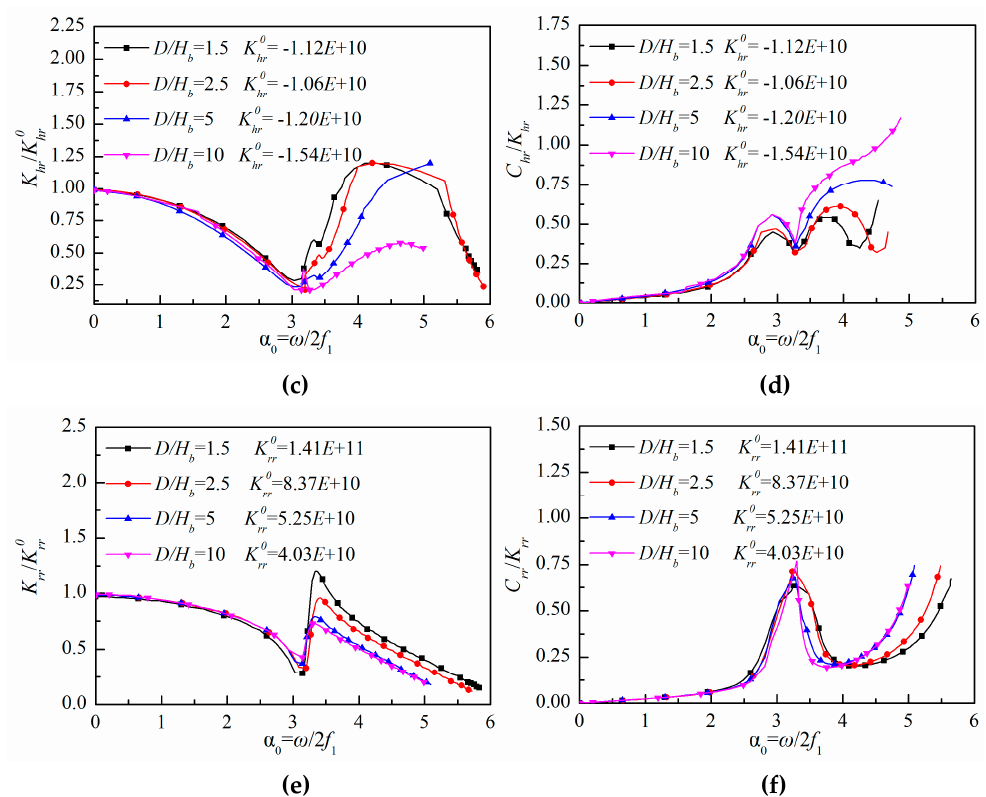
Figure 9. Variation of three dynamic impedance coefficients with respect to the dimensionless frequency under effect of the slenderness ratio by varying the skirt length: ( a ) Horizontal stiffness coefficient; ( b ) horizontal damping coefficient; ( c ) coupling stiffness coefficient; ( d ) coupling damping coefficient; ( e ) rocking stiffness coefficient; ( f ) rocking damping coefficient.